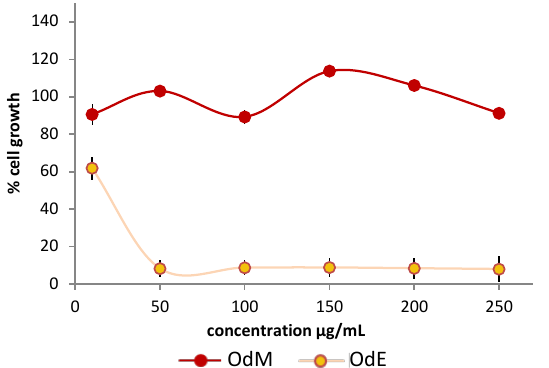
Figure 5. Antiproliferative activity evaluation of the O. diffusa partially purified fractions on HT-29 cell lines. Cell growth is expressed as percentage from control, and it is plotted on the vertical axis, while doses of plant extracts are reported on the horizontal axis.